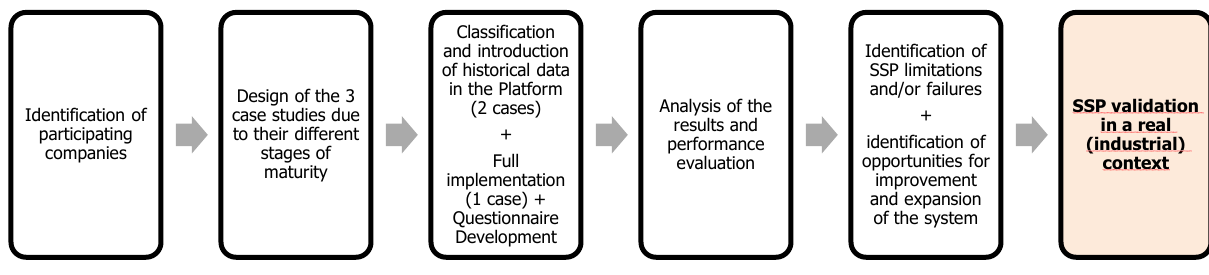
Figure 2 . Diagram of the study